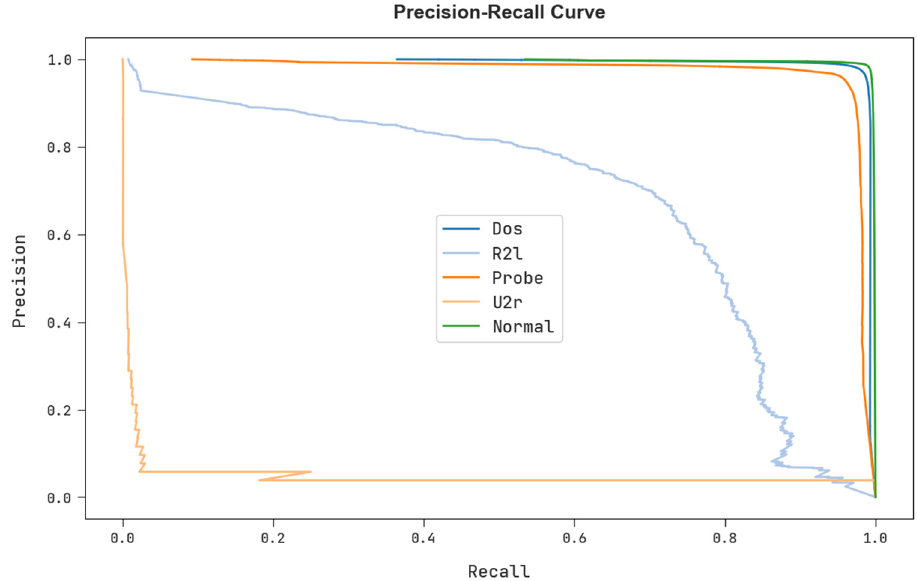
Figure 10. Precision-recall analysis of FSHDBN-CID algorithm.